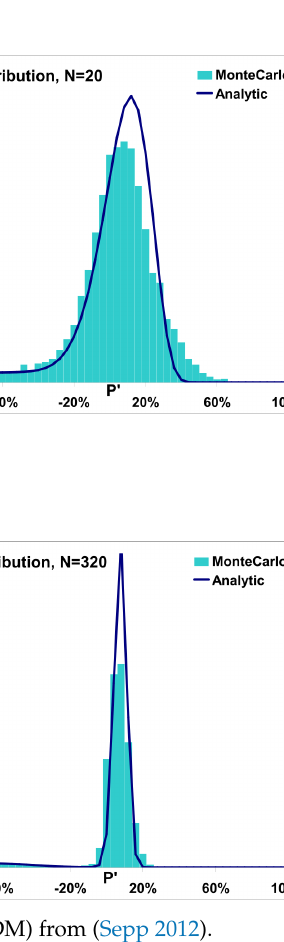
Figure 8. Profit and loss distributions for delta hedging under jump diffusion models (JDM) from (Sepp